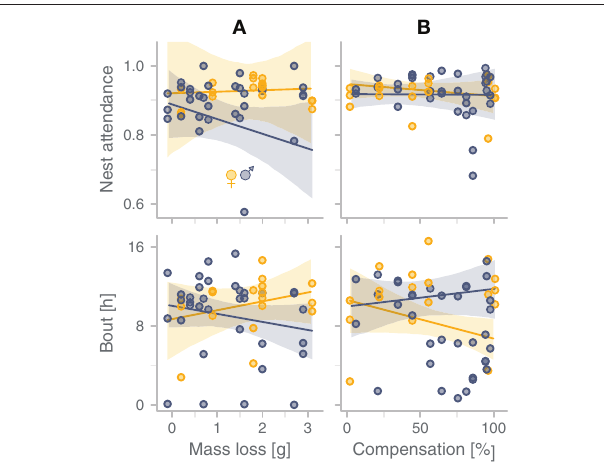
FIGURE 7 | Predictors of nest attendance and bout length during the after-experimental period. (A) Relationship between mass loss of the removed parent while in captivity and its nest attendance and bout length during the post-experimental period. (B) Relationship between the amount of compensation by the focal parent during the time the removed partner would have incubated (treated period) and the focal parent’s nest attendance and bout length during the after-experimental period. (A,B) Yellow indicates females, blue-gray males; dots represent individual observations and lines with shaded areas indicate model predictions with 95%CI. In all four cases the model with sex fitted the data better (Tables S6, S7 in Bulla,